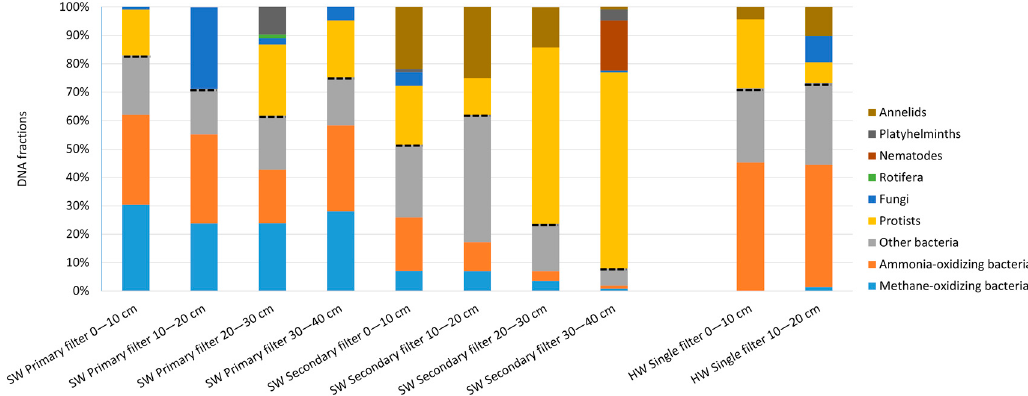
Figure 2. Fractions of DNA from organisms in filter sand samples from Slangerup waterworks (SW) and Hvidovre waterworks (HW). Samples were collected at different depths, starting with 0 cm at the top of the sand. Dashed lines separate prokaryotes from eukaryotes.